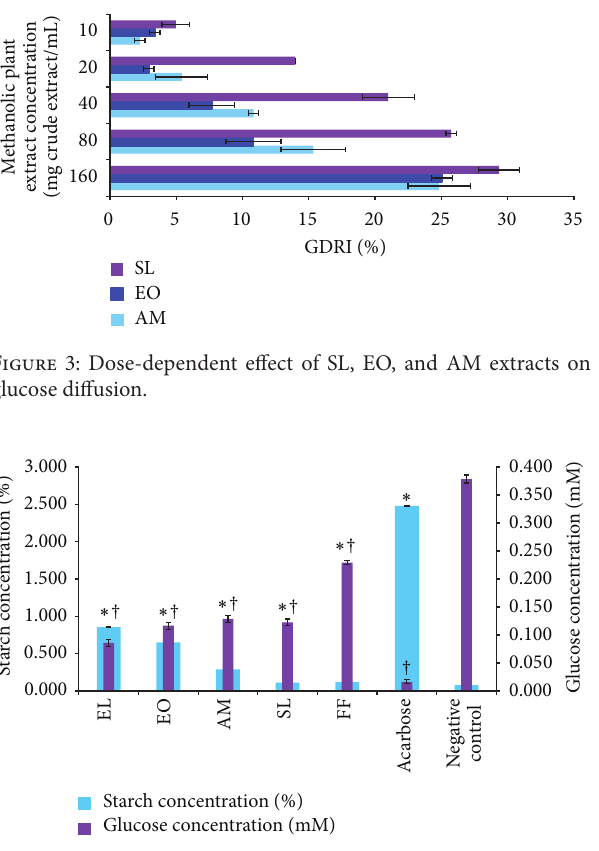
Figure 4: Percentage starch of reaction mixture and glucose con- centration of dialysate in the presence of aqueous extracts. ∗ Values [starch (%) concentration] significantly ( 𝑃 < 0.05 ) higher than neg- ative control. † Values [glucose (mM) concentration] significantly ( 𝑃 < 0.05 ) lower than negative control. Table 2: Kinetic parameters of active plant extracts on 𝛼 -amylase activity in